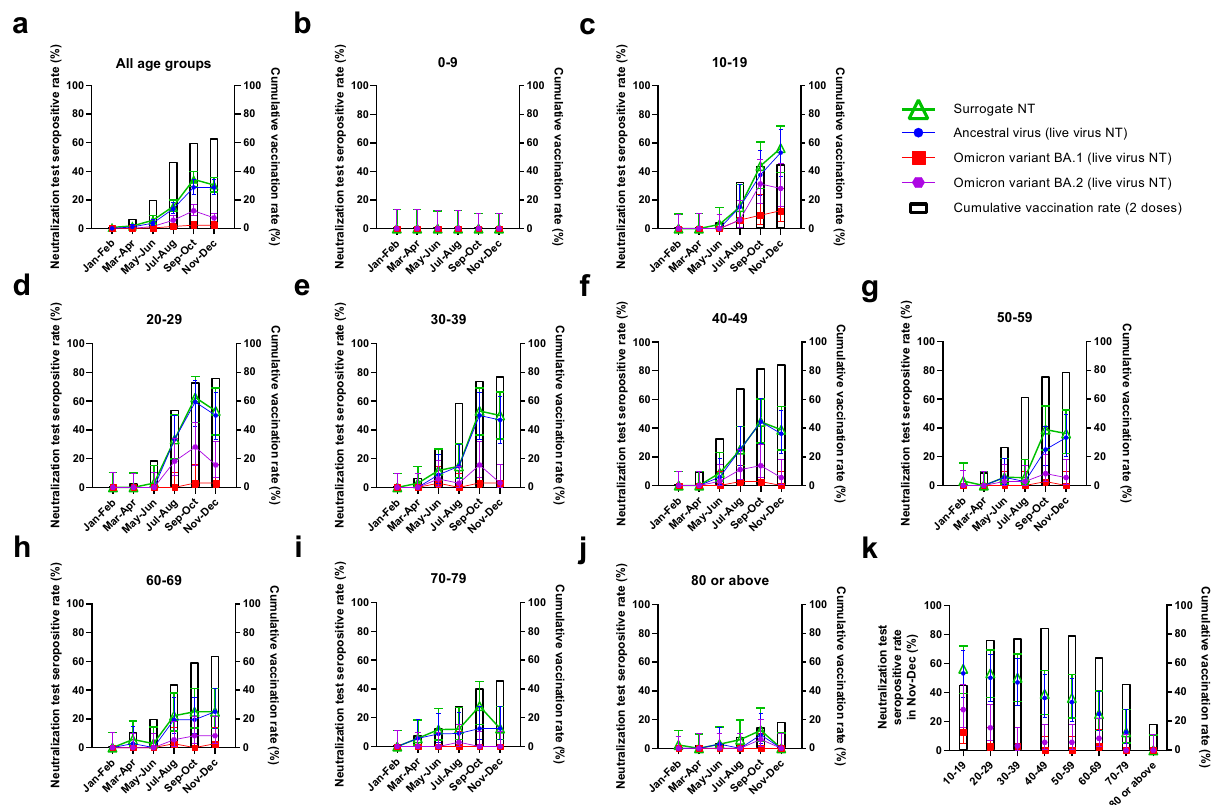
Fig. 1 Cumulative two-dose vaccination uptake rates and neutralization test seropositive rates for ancestral virus and Omicron variant sublineages in 2021. a – j Cumulative two-dose vaccination rates and neutralization test (NT) seropositive rates of different age groups between January and December 2021. k Two-dose cumulative vaccination uptake rates and neutralization test seropositive rates in November/December 2021. a – k Cumulative vaccination rate represents the percentage of the population that have received 2 doses of COVID-19 vaccines at the end of each time period 34 . Neutralization test seropositive rates represent the percentage of sera tested positive in each time period. All serum specimens were tested with the surrogate virus neutralization test (sVNT) (iFlash-2019-nCoV neutralization antibody assay), which measures antibodies that block the interaction between ancestral virus receptor binding domain (RBD) and human angiotensin-converting enzyme 2 (ACE2). Serum specimens tested positive in the sVNT were then tested for NAb against the ancestral virus, Omicron sublineage BA.1 and Omicron sublineage BA.2 using a conventional live virus neutralization test (cVNT). A